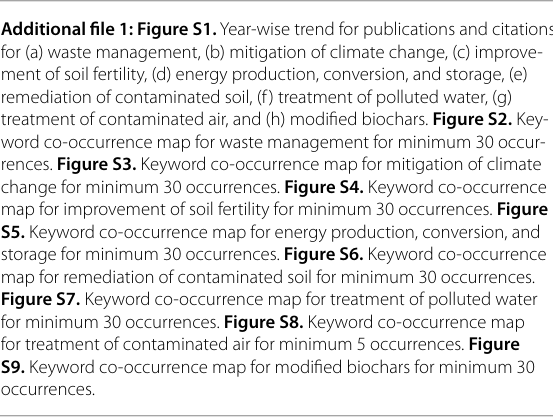
Figure S7. Keyword co-occurrence map for treatment of polluted water for minimum 30 occurrences. Figure S8. Keyword co-occurrence map for treatment of contaminated air for minimum 5 occurrences. Figure S9. Keyword co-occurrence map for modified biochars for minimum 30